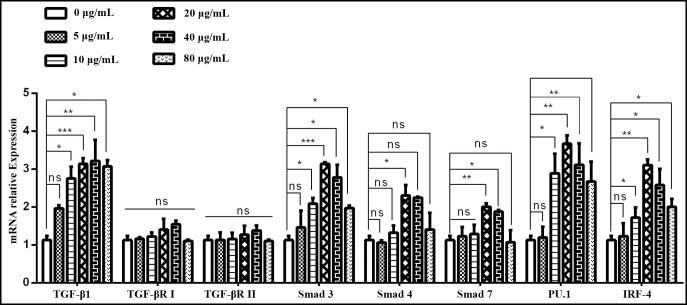
Relative expression of TGF-β/Smad signaling pathway key genes in goat PBMCs stimulated by the ESPs.Cells were incubated with the serial concentration of ESP for 48 h and the mRNAs encoding TGF-β/Smad signaling pathway key genes a reverse-transcription-polymerase chain reaction quantified TGF-β1, TGF-βRI, TGF-βRII, Smad3, Smad4, Smad7, PU.1 and IRF-4. The significant level were set at *p < 0.05, **p < 0.01, ***p < 0.001 and ns non-significant compared with the untreated group (control). Data are representative of three independent experiments.